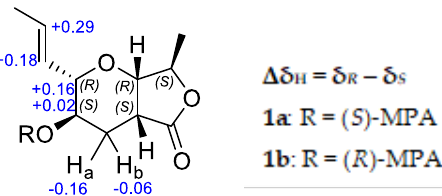
Figure 4. Δδ H values obtained for ( S )-MPA and ( R )-MPA ester derivatives ( 1a and 1b , respectively) of 1 in CDCl 3 .